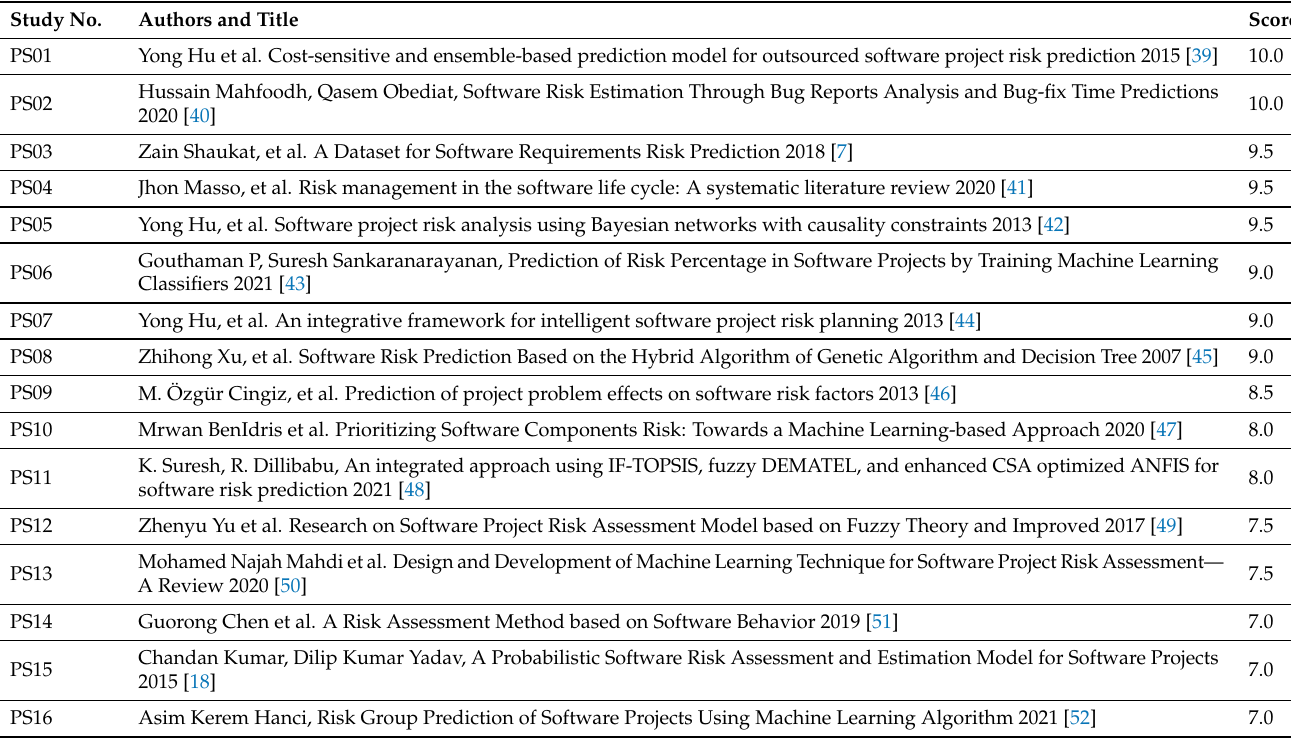
Table 6. Scores of quality of PS under the categories ‘very high’ and